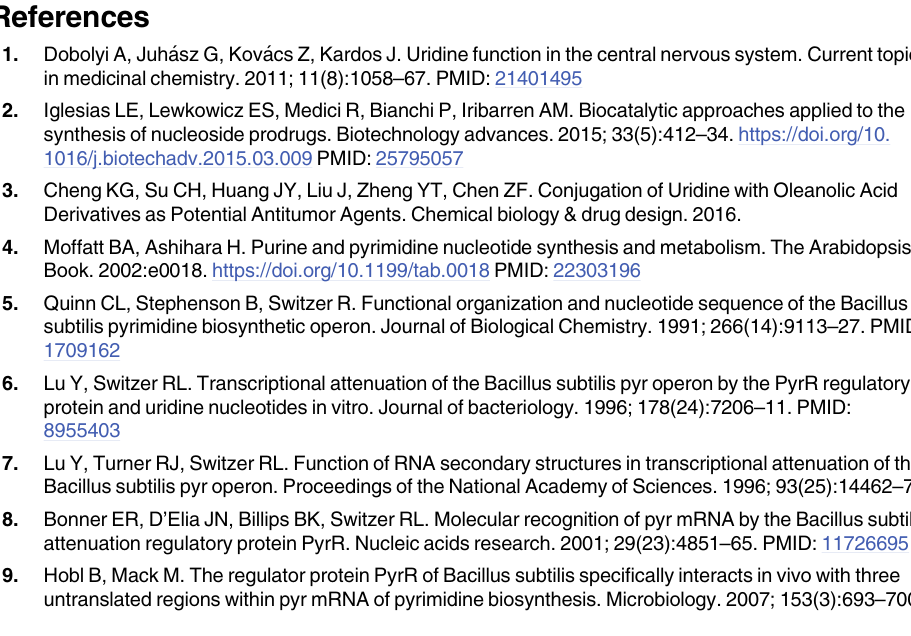
S2 Fig. Lethality rate of B. subtilis under different irradiation time. (TIF) S3 Fig. Uridine titer of mutants isolated from 2-thiouracil-resistance plate. (a) 200 mg/L 2-thiouracil; (b) 300 mg/L 2-thiouracil; (c) 400 mg/L 2-thiouracil. (TIF) S4 Fig. Uridine titer of mutants isolated from 6-azauracil-resistance plate. (a) 100 mg/L 6-azauracil; (b) 3 g/L 6-azauracil. (TIF) S5 Fig. Uridine titer of mutants isolated from 200 mg/L 5-fluorouracil-resistance plate. (TIF) S1 Table. Primers for sequence analysis and site mutagenesis.